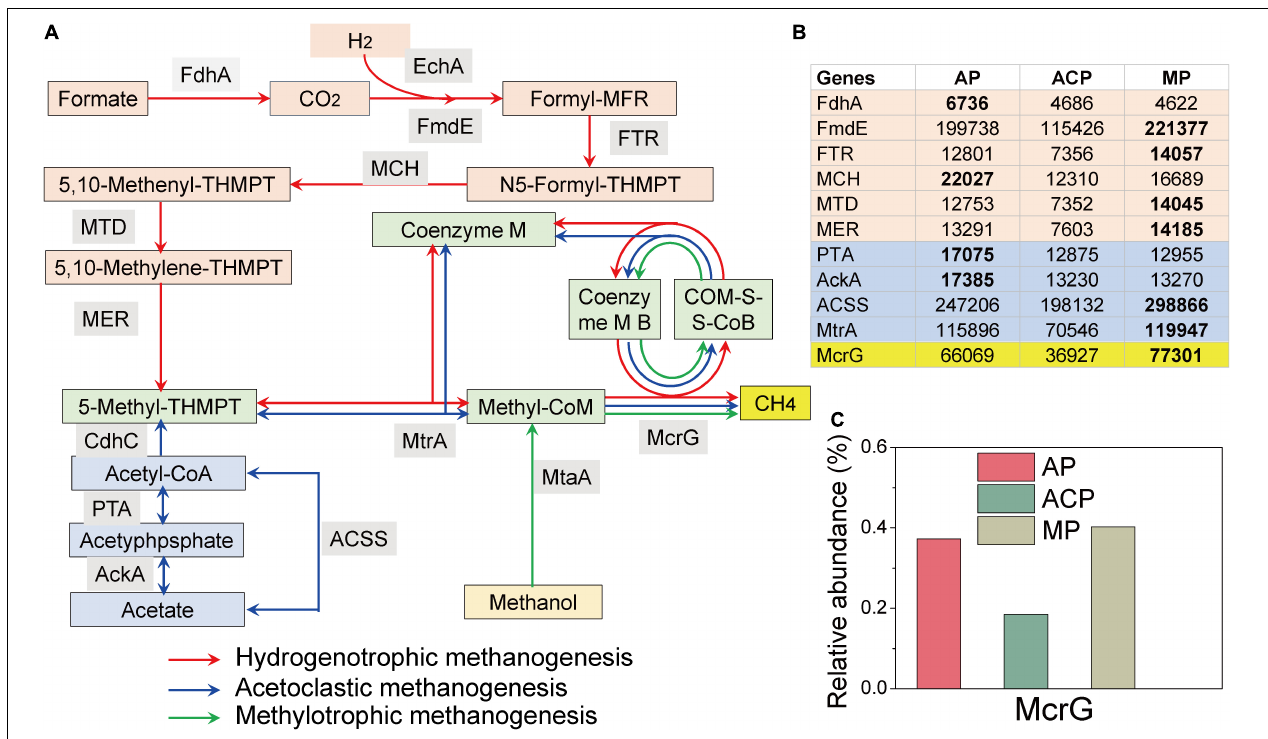
FIGURE 6 | Hit reads of genes involved in the hydrogenotrophic (red line), acetoclastic (blue line), and methylotrophic (green line) methanogenesis pathways during solid waste decomposition (A) . (B) The hit reads of relevant genes. (C) The relative abundance of the core mcrG gene. The methanogenesis pathway figure (Yang et al., 2021) was modified based on Li et al. (2017a). FdhA, glutathione-independent formaldehyde dehydrogenase; EchA, hydrogenase subunit A; FmdE, formylmethanofuran dehydrogenase subunit E; FTR, formylmethanofuran-tetrahydromethanopterin N -formyltransferase; MCH, methenyltetrahydromethanopterin cyclohydrolase; MTD, methylenetetrahydromethanopterin dehydrogenase; MER, coenzyme F420-dependent N5, N10-methenyltetrahydroethanopterin reductase; MtrA, tetrahydromethanopterin S-methyltransferase; MtaA, [methyl-Co(III) methanol-specific corrinoid protein]: coenzyme M methyltransferase;